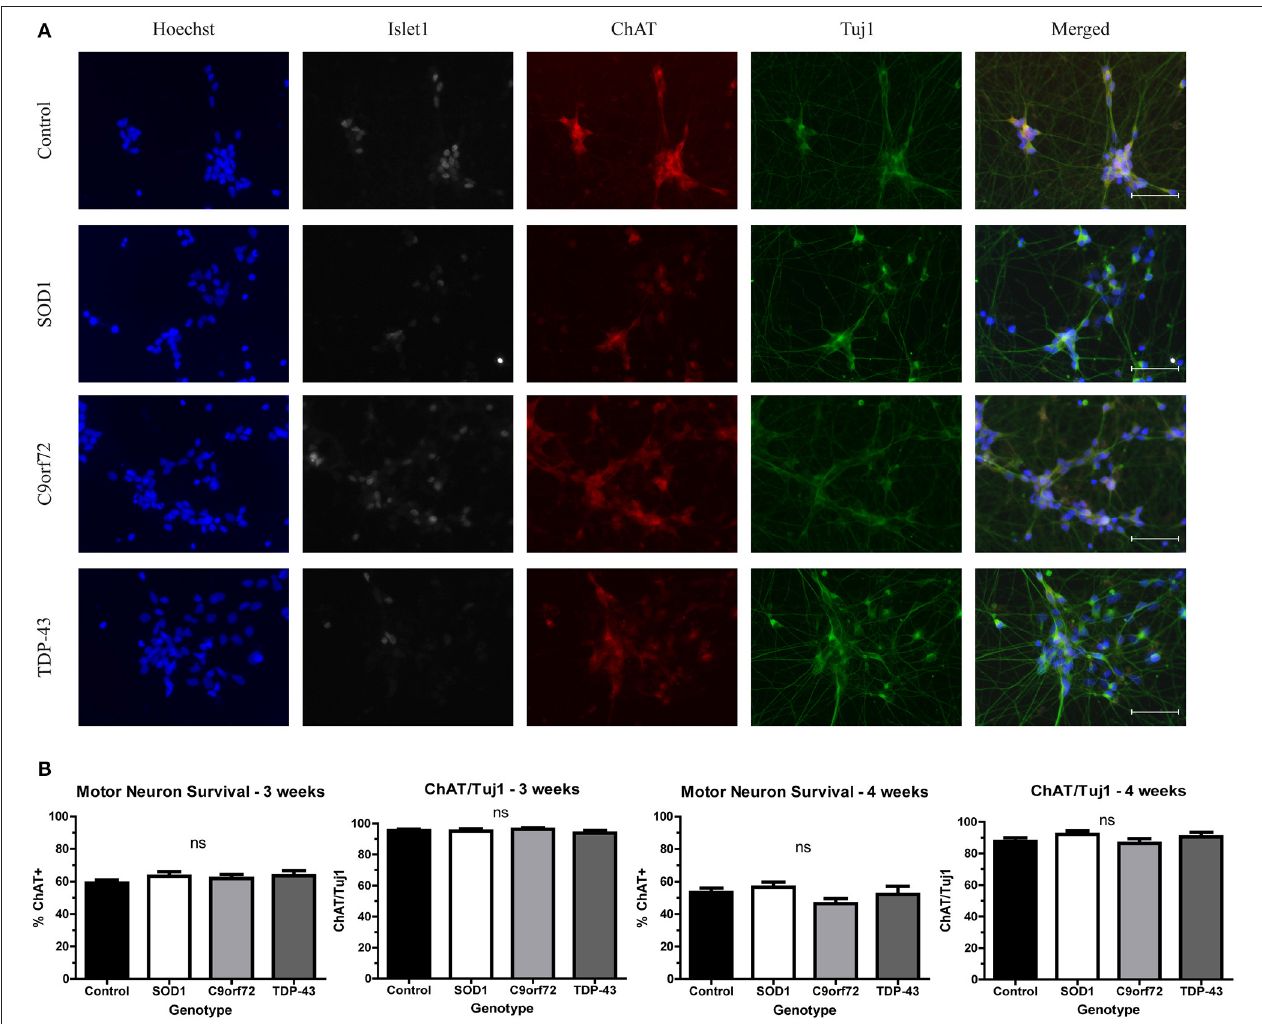
FIGURE 1 | iPSC-derived motor neurons from multiple ALS genotypes do not exhibit reduced viability in culture. (A) Representative images at 3 weeks of differentiation of control and ALS motor neurons immunostained for Tuj1 (green), ChAT (red), and Islet1 (white). Nuclei are labeled with Hoechst nuclear dye (blue). Scale bar = 50 µ m. (B) Quantification shows no difference in the number of motor neurons at 3 or 4 weeks of differentiation. n = 3–4. Not significant by one-way ANOVA with Tukey post-hoc test.